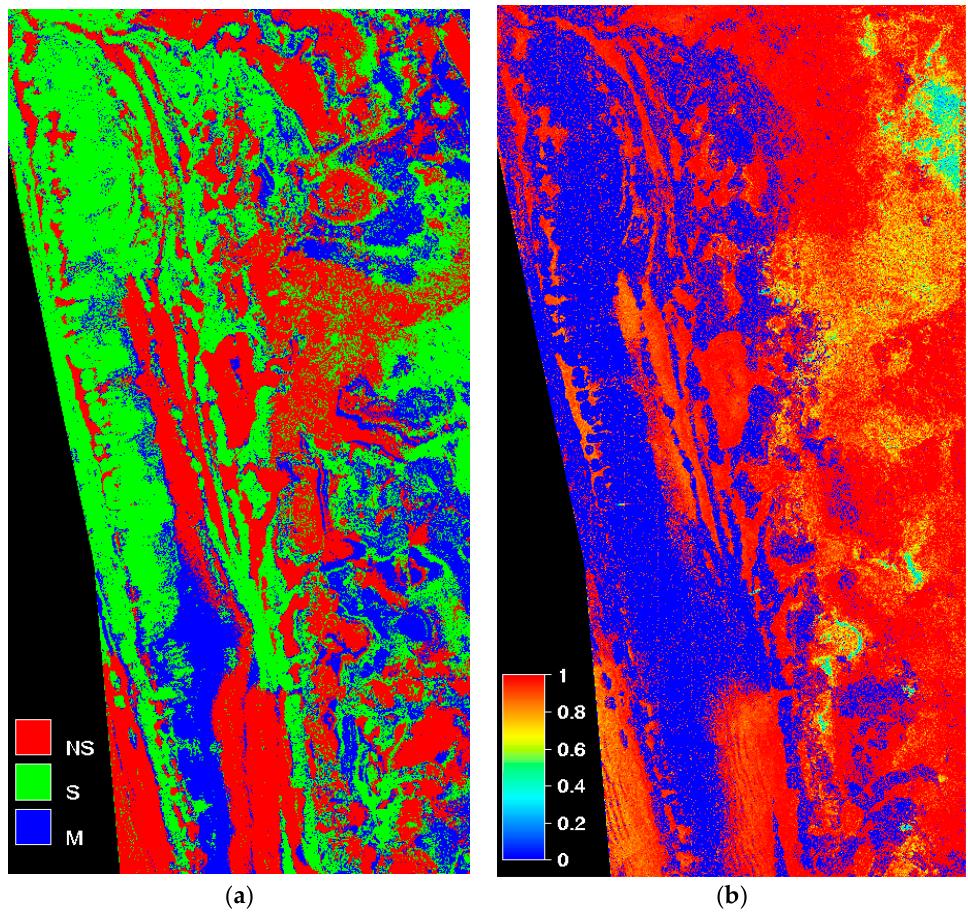
Figure 5. ( a ) Classified map, showing non-sand (NS), sand (S), and mixed (M) pixels. ( b ) A map of the SAMBUCA q values from Equation (1), showing the estimated proportion of the dark substrate, ρ 1 .